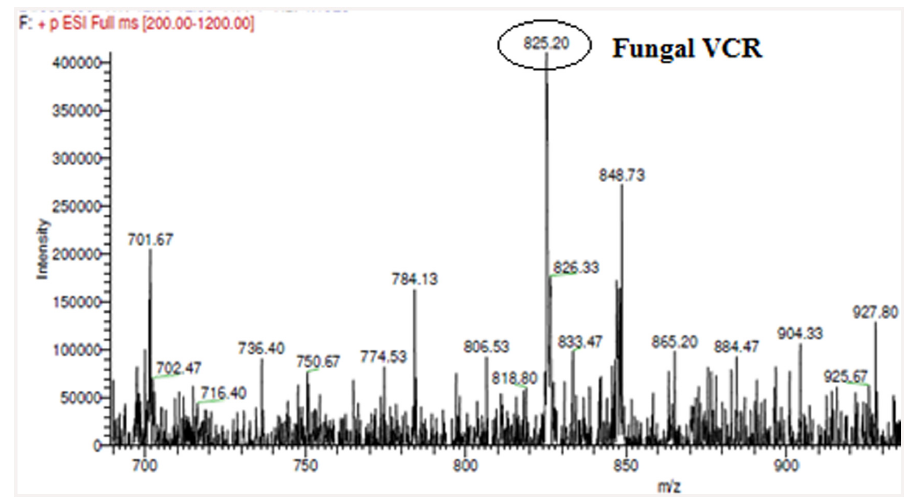
Fig 9. LC-ESI-MS analysis. of fungal VCR. The mass spectrum of the fungal extract showed a (M+H + ) peak at a molecular mass of 825.46, which was identical to that observed in the mass spectrum of the VCR standard.